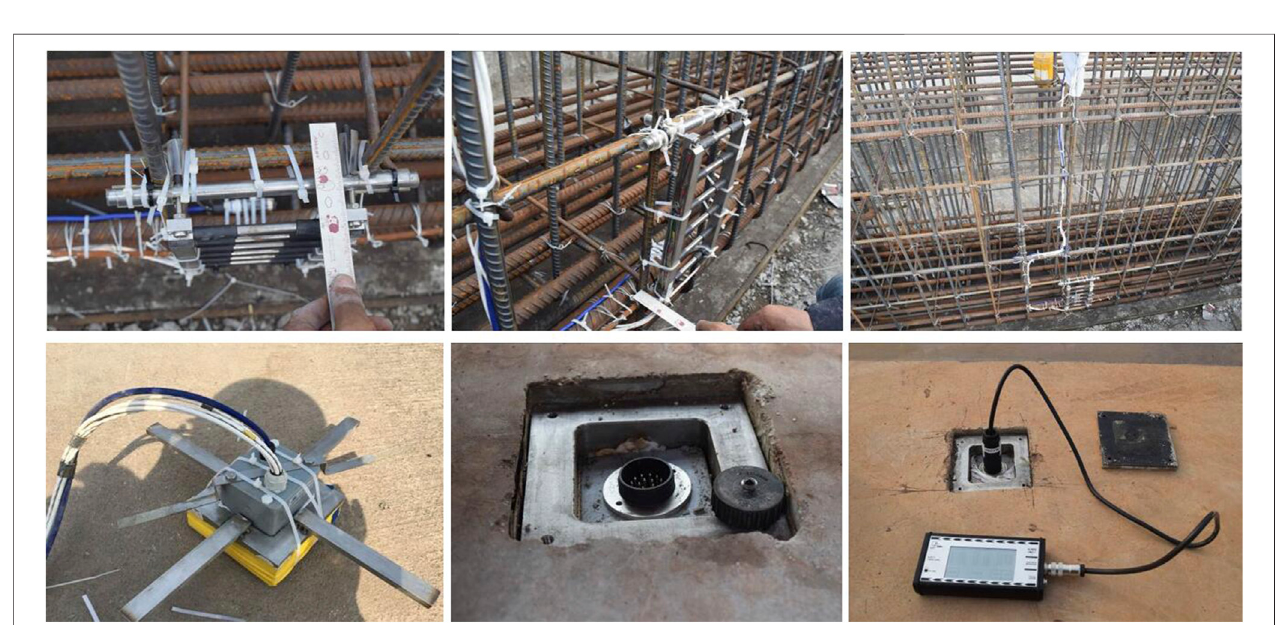
FIGURE 5 | Installation of anode-ladder sensor and fi eld data acquisition.